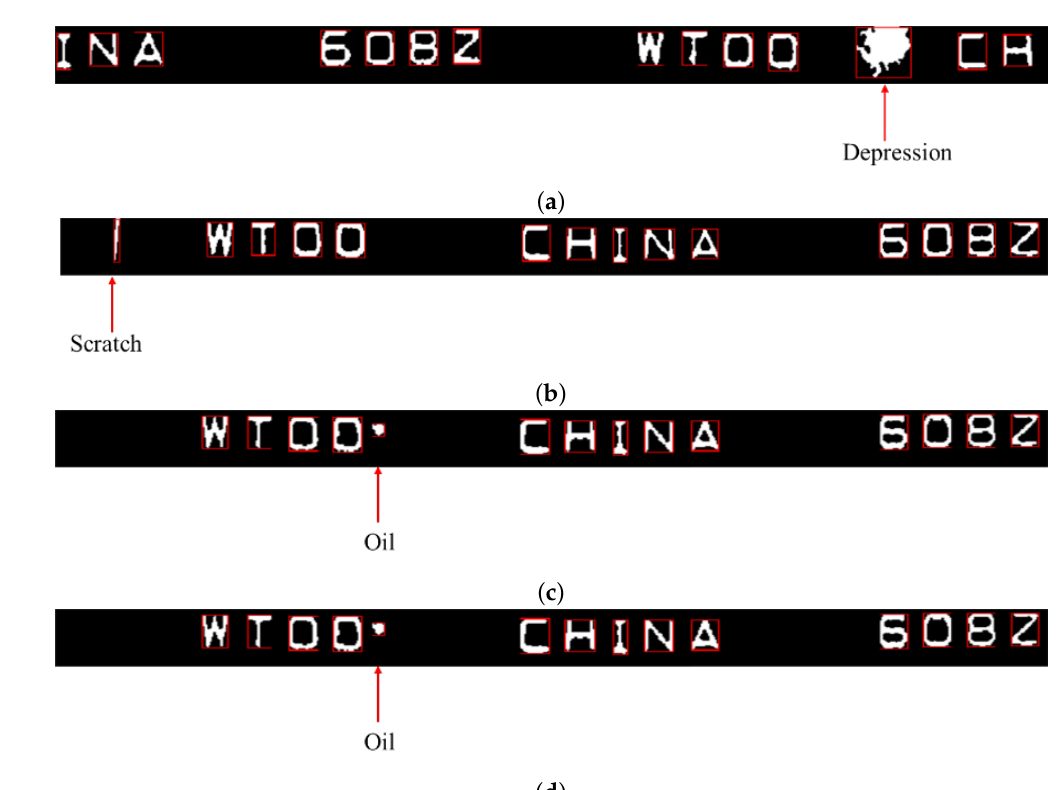
Figure 14. Defects in the non-character regions. ( a ) Depression in the band of dust cover. ( b ) Scratch in the band of dust cover. ( c ) Oil in the band of dust cover. ( d ) Scratch in the band of outer ring.